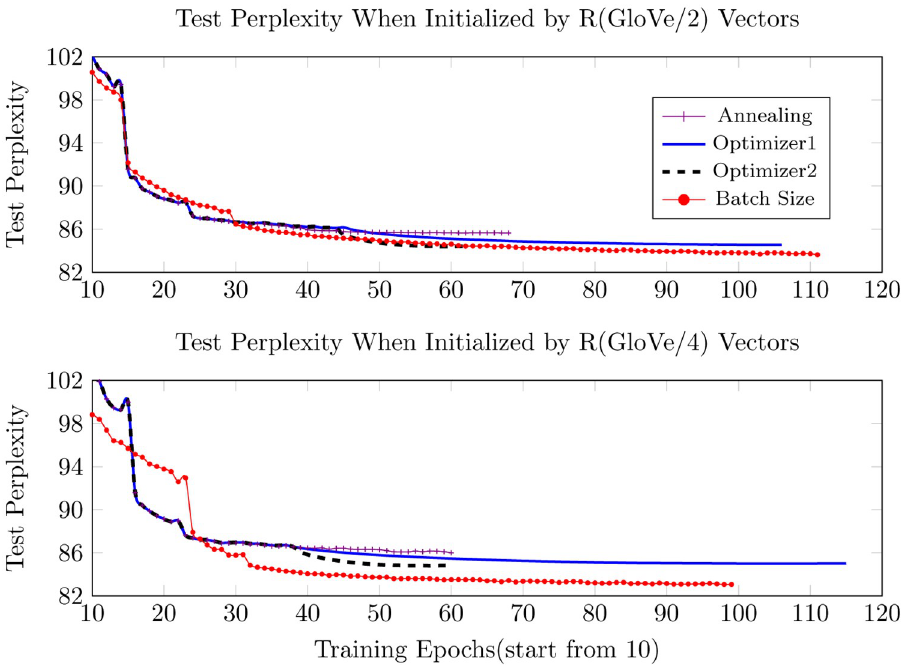
Fig 6. Test perplexity when initialized by random GloVe